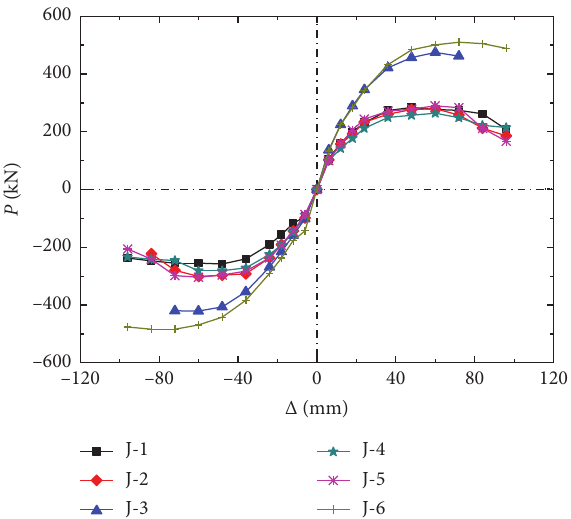
Figure 14: Load-displacement skeleton curves of the